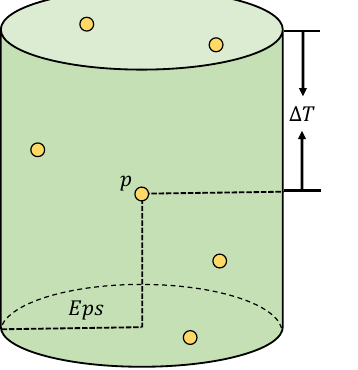
Figure 1. Schematic representation of the spatial-temporal neighborhood.